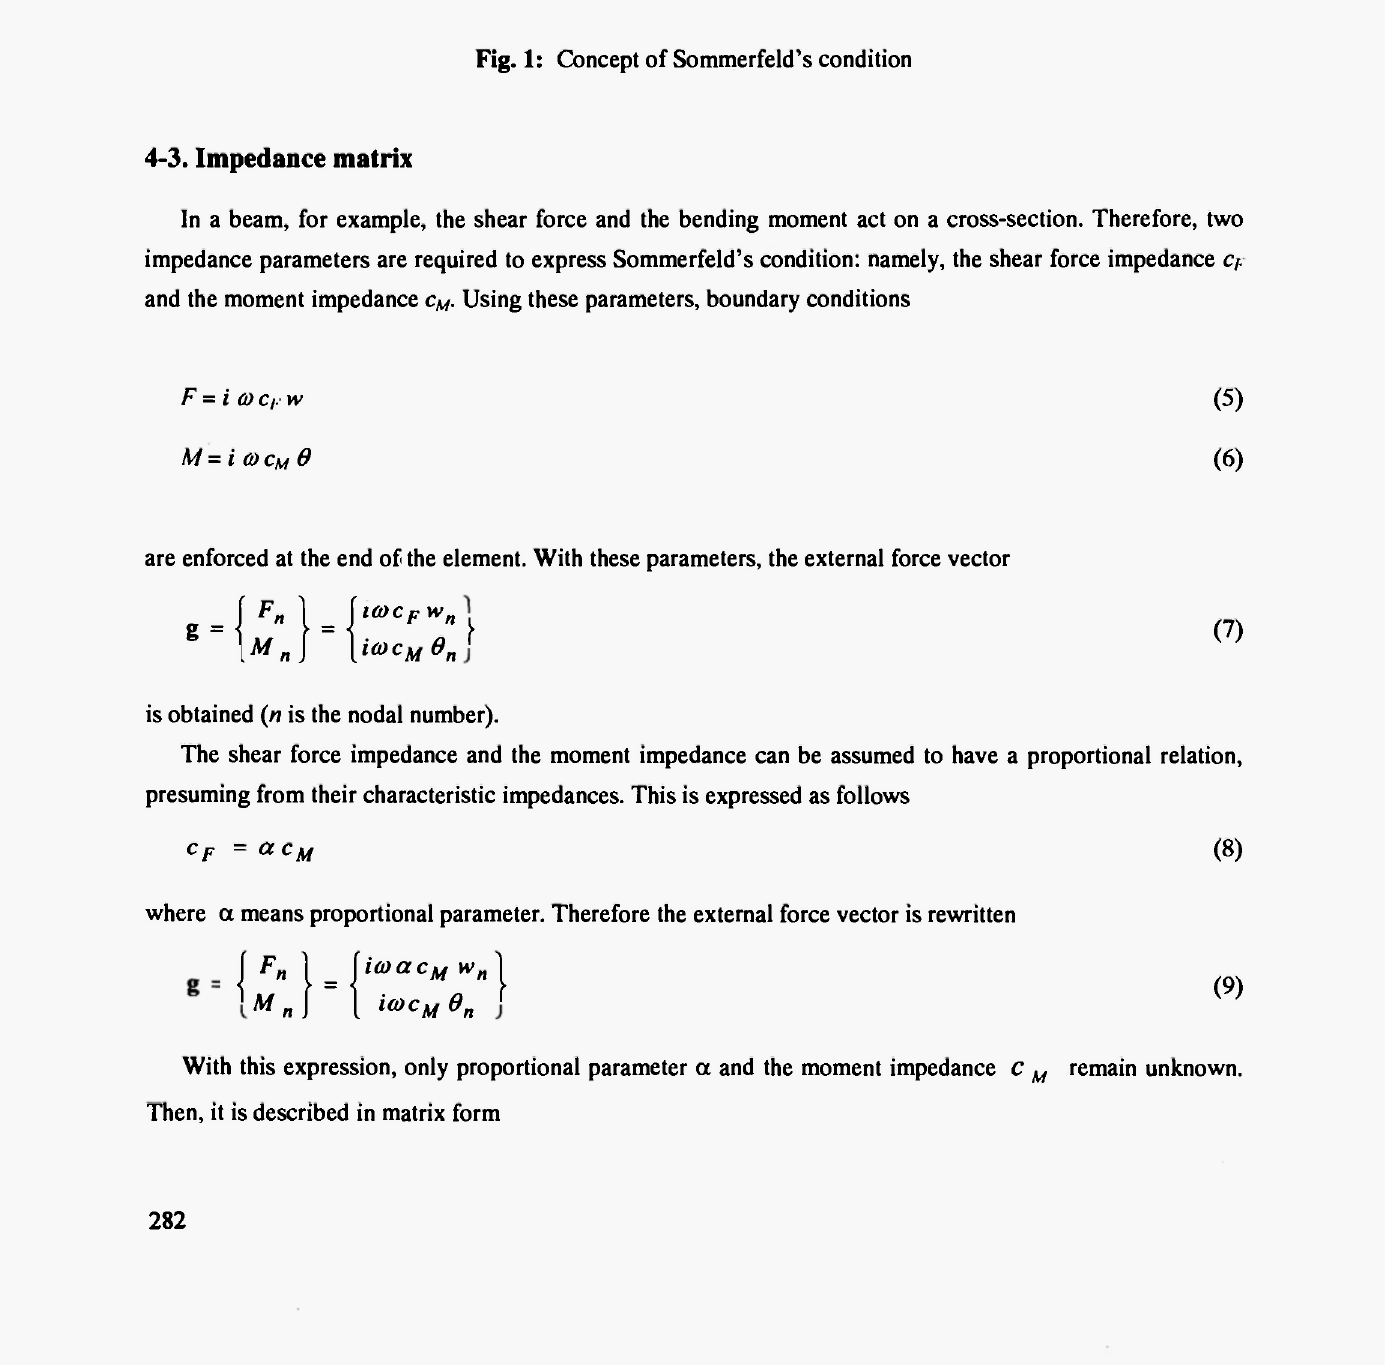
Fig. 1: Concept of Sommerfeld's